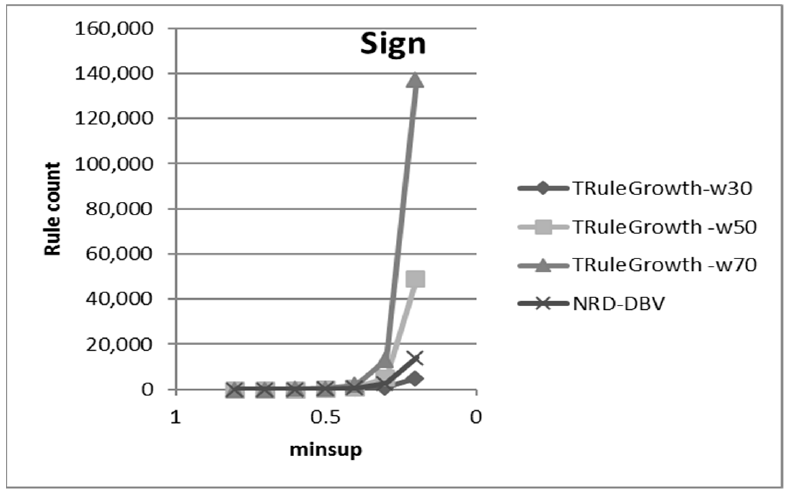
Figure 8. Comparison between the No. of rules generated for the TRuleGrowth and the NRD-DBV for (Sign) dataset.